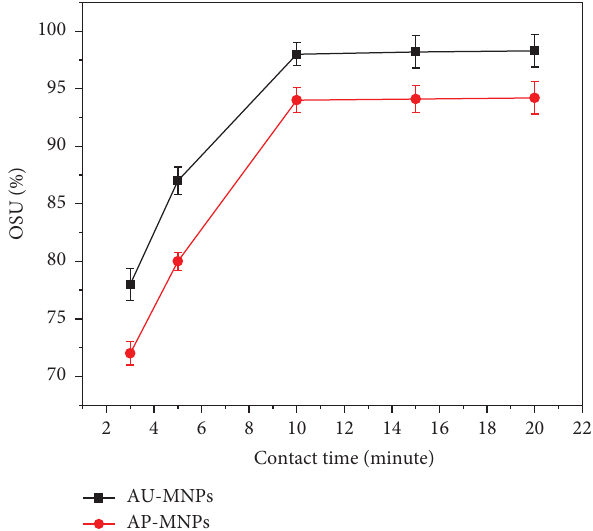
Figure 11: OSU of AU-MNPs and AP-MNPs versus contact